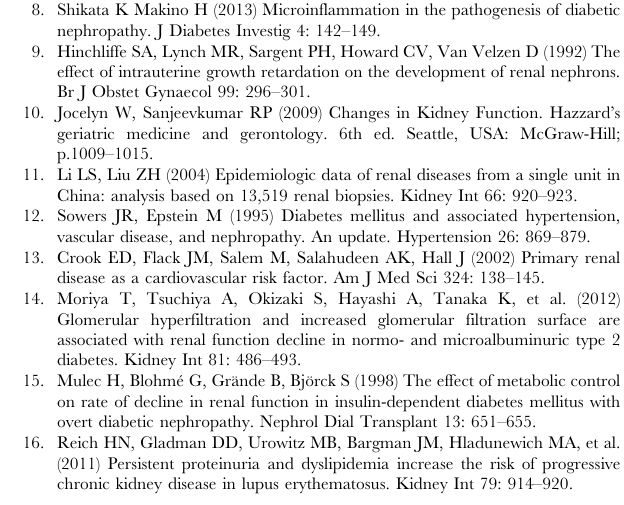
Figure S1 Concordance was found with a positive correlation between MDRD and CKD-EPI. (TIF) Figure S2 The similar distribution of estimated GFR and eGFR-risk relationship were found between the CKD-EPI equation (red) and the MDRD Study equation (black) in our CKD cohort. (TIF) Figure S3 The positive correlation and distribution of eGFR between MDRD and CKD-EPI were shown by age categories ( , and $ 65 years) in the CKD cohorts (female).